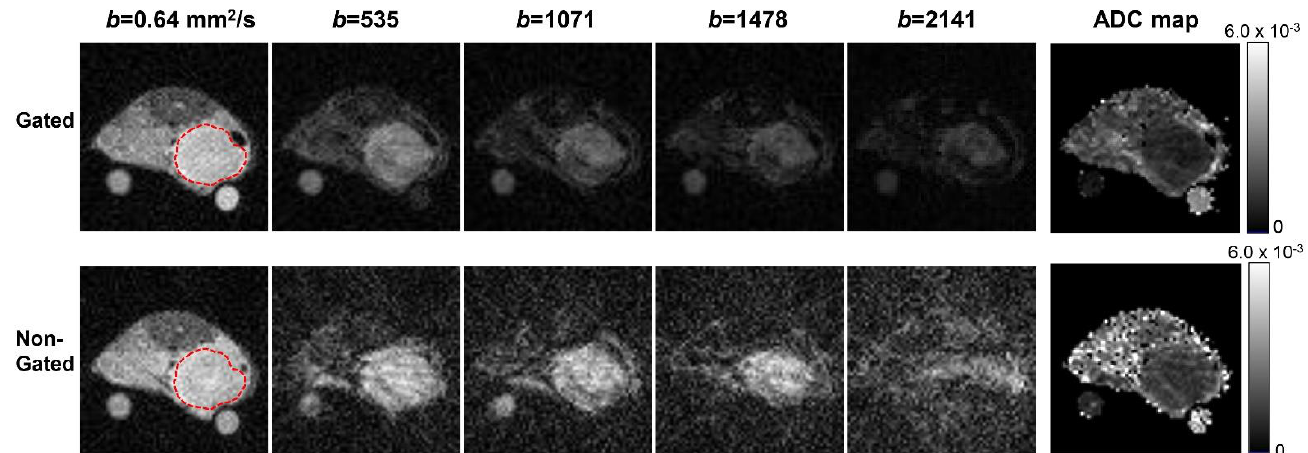
Figure 1. Diffusion-weighted images and the resulting apparent diffusion coefficient (ADC) maps from the radially sampled diffusion-weighted spin-echo (DW-SE-RAD) protocol with and without prospective respiratory gating. The ADC estimates of the tumor (mean ± SD from multiple slices spanning the tumor in units of × 10 − 3 mm 2 /s) are 1.1 ± 0.097 vs. 1.3 ± 0.17 (gated vs. non-gated), while estimates of the diffusion coefficient of the water phantom (in units of × 10 − 3 mm 2 /s) are 3.2 ± 0.13 vs. 4.0 ± 0.30 (gated vs. non-gated).